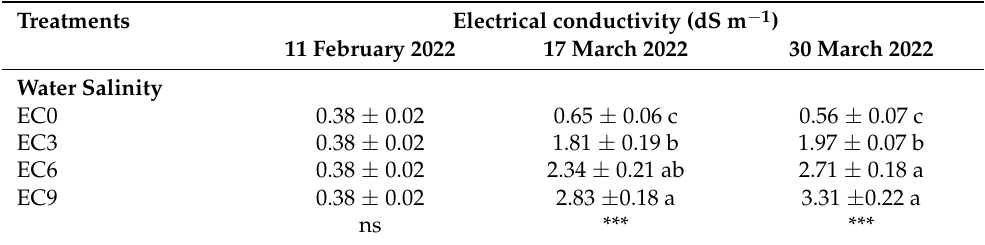
Table 1. Soil electrical conductivity values (mean ± SD; dS m − 1 ) throughout the spinach growth cycle in relation to saline water